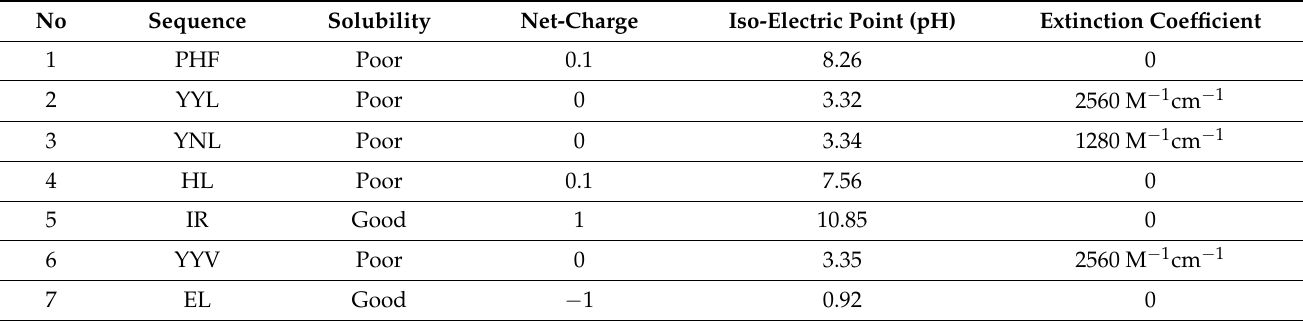
Table 3. Physicochemical characterization of peptides derives from glycinin and conglycinin with antioxidant activities.